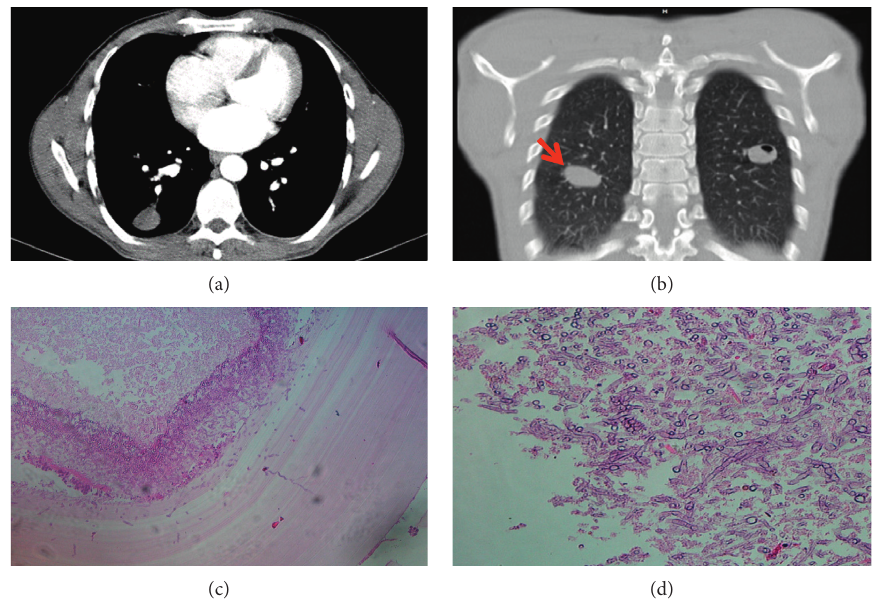
Figure 1: (a) CTscan (transverse view) revealing hydatid cyst in superior and inferior segment of the lower lobe of the right and left lungs, respectively. (b) CTscan (frontal view) indicates hydatid cyst in superior and inferior segment of the lower lobe of the right and left lungs, respectively. (c) Fungal hyphae on the outer chitinous wall of the hydatid cyst in the right lung (H&E × 100). (d) Photomicrograph showing groups of branching septate hyphae conforming to morphology of Aspergillus in hydatid cyst tissue in the right lung (H&E × 400).